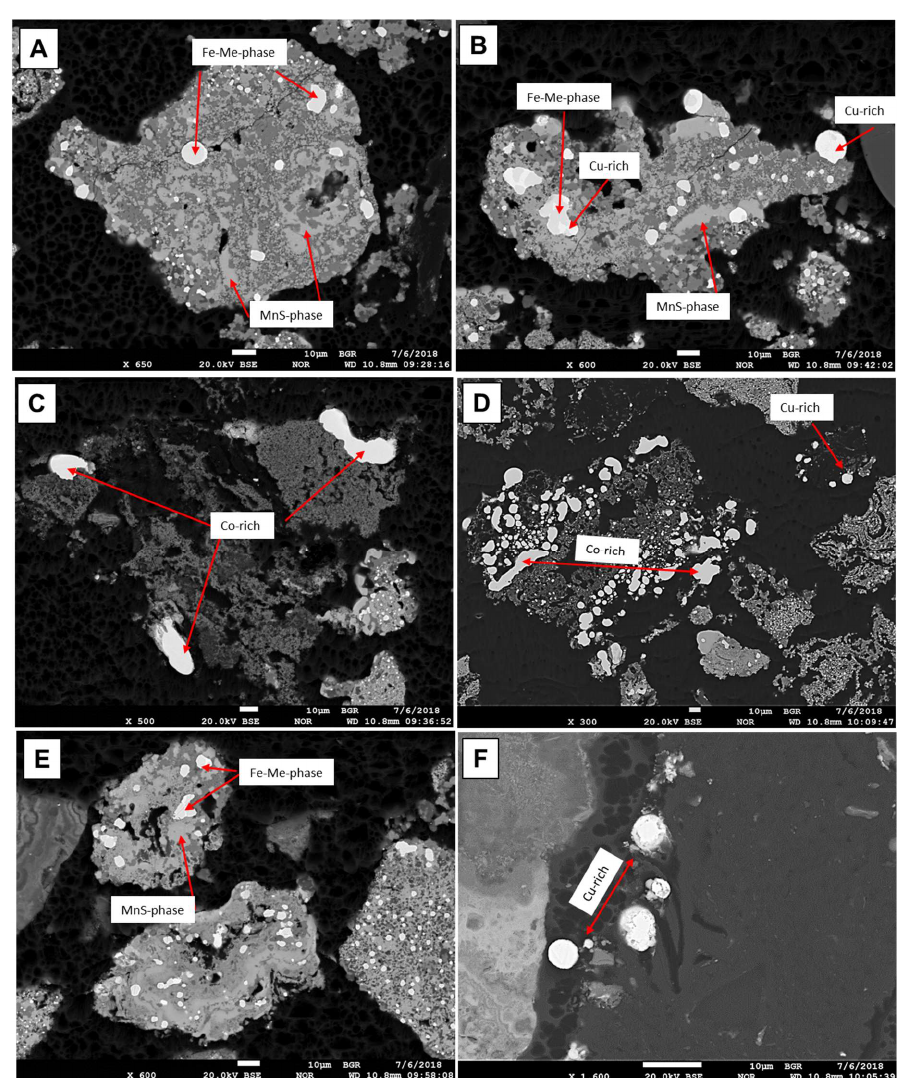
Figure 7. BSE images of different metal-bearing particles of samples P3 and P4, with bright particles representing the metal-bearing phases. They have a high variability of the incorporated economically interesting metals. ( A , B ) Bright particles are distributed within former nodule material, which is transformed, now consisting of Fe-Me-phase and MnS phase intermixed with Mn-oxides and Mn-silicates. ( C – F ) Metal-bearing particles that are preferentially enriched in Cu or Co, located near coke particles.